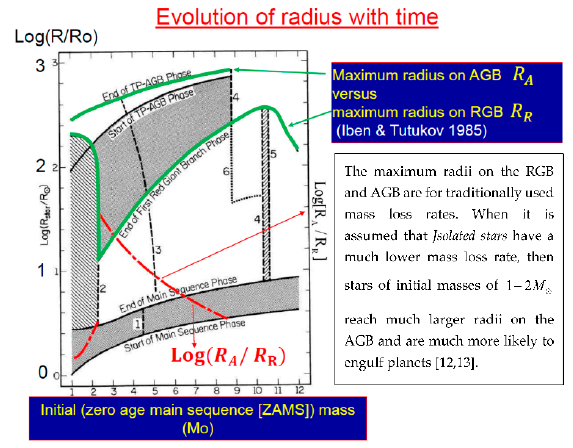
Figure 1. Maximum radii stars reach on their RGB and AGB as function of their initial mass for traditional mass-loss rates (from [11]).